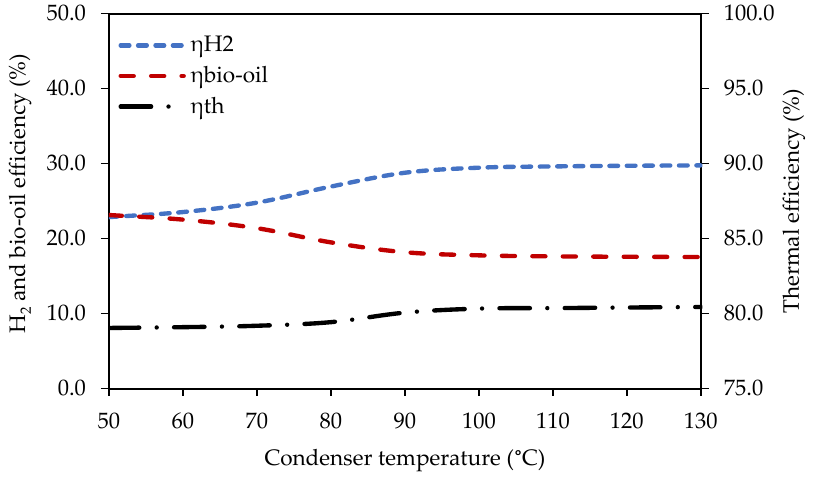
) and total thermal ( 𝜂 𝑡ℎ ) efficiencies of Scheme 2 production system at different Figure 10. H 2 ( 𝜂 𝐻 2 temperatures of the bio-oil condenser.